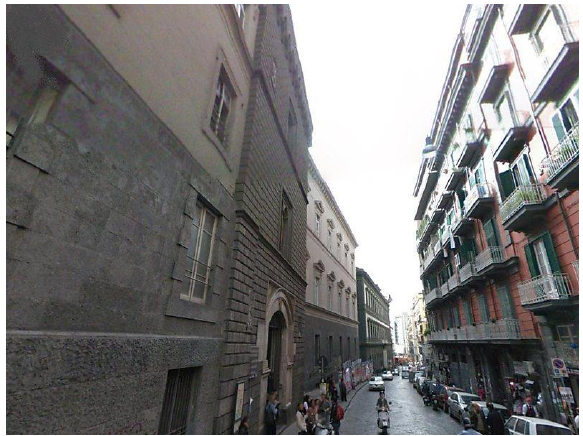
Figure 9. Napoli. Via Mezzocannone